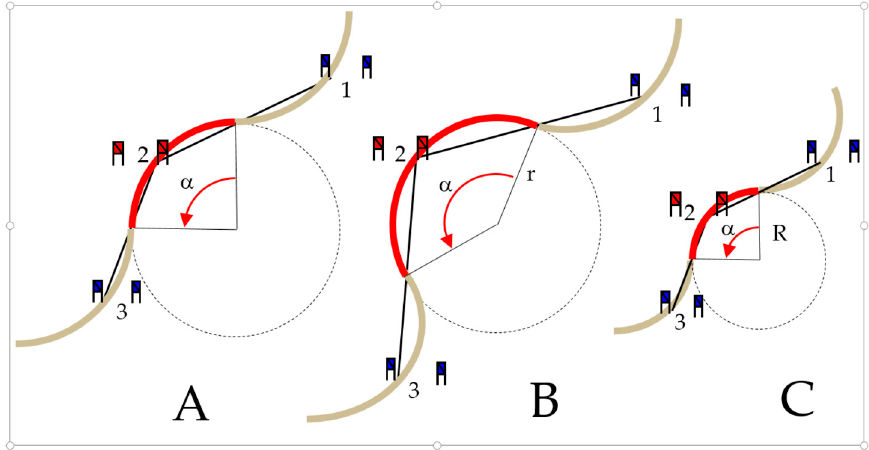
Figure 6. ( A )- and ( B )-turns with the same radius r, but with different central arc angles α , ( A ) and ( C )-turns with different radii r, but with the same central arc angle α .